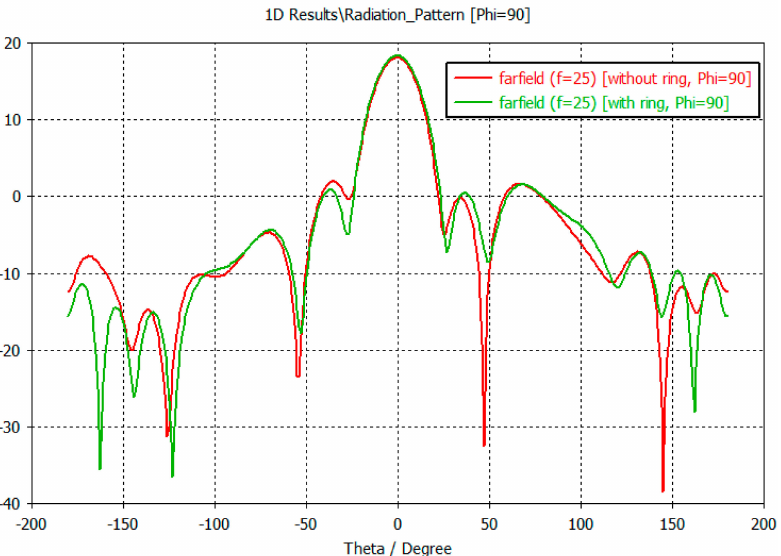
Figure 22. The radiation pattern of the microstrip antenna array with 24 elements, simulated with CST MWS, without, and with an SLL suppression ring (Phi = 90